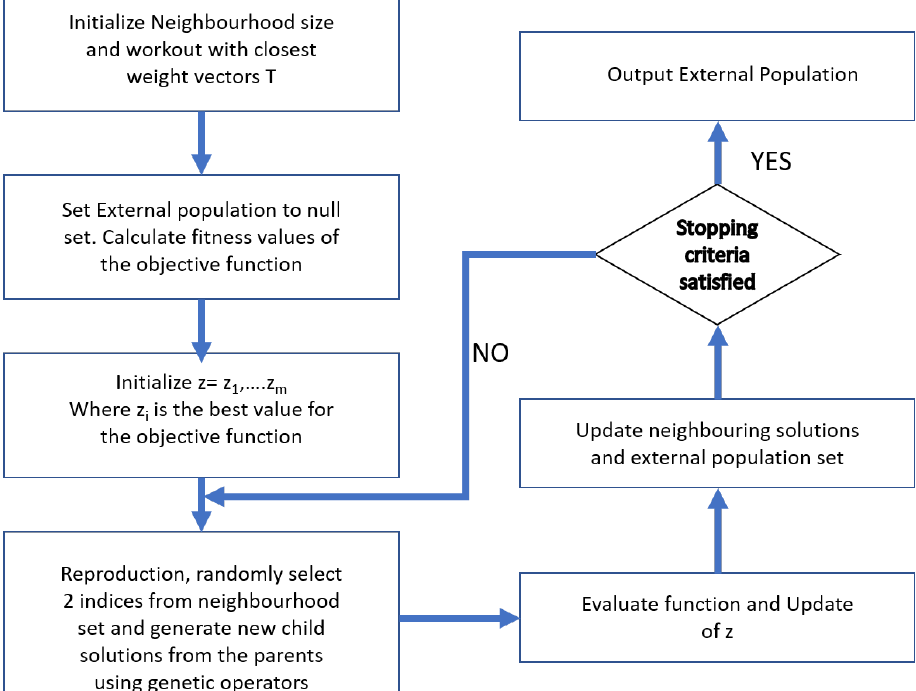
Figure 6. Procedure for MOEA/D algorithm